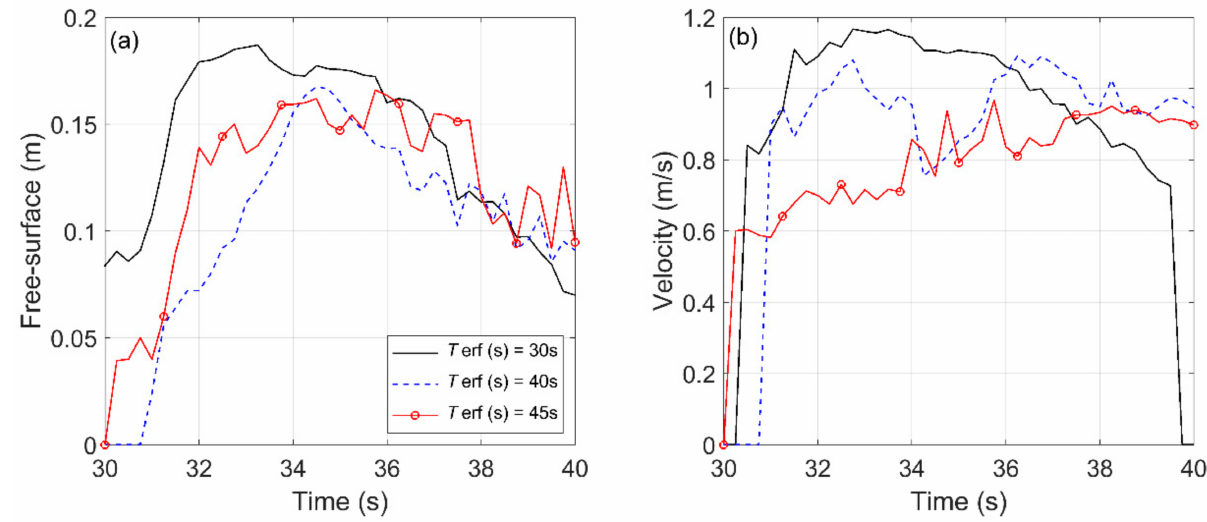
Figure 12. Variation of free surface ( left ) and fluid velocity ( right ) at x = 62 m: Numerical results for h 1 = 2.496 m and three wave cases with T erf = 30, 40, and 45 s.